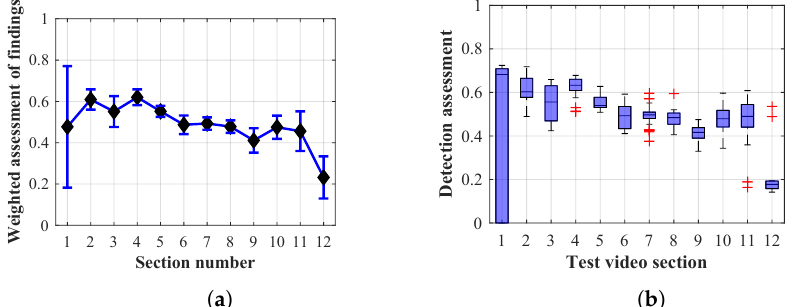
Figure 28. ResultsofMethod1.1withalifespanof12frames. ( a )theweightedaverageratingwiththeaverage mean absolute error of the weighted rating and ( b ) boxplots of the distribution of the statistical sets of the results of the individual sections evaluated indicating: minimum, 1st quartile, median, 3rd quartile, maximum.